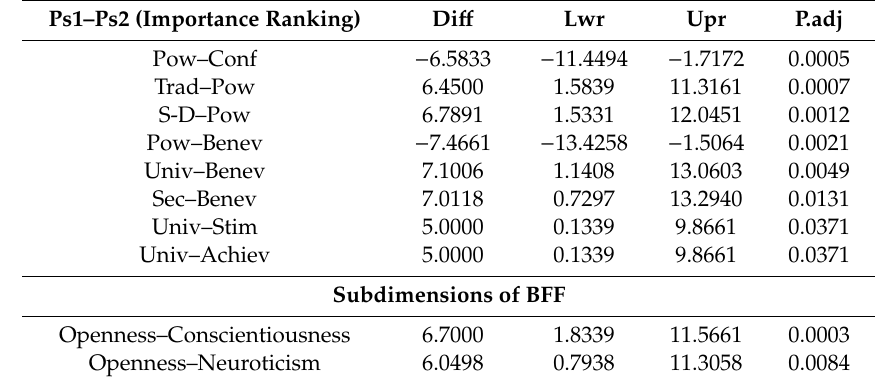
Figure 9. Multiple comparisons between all pairs (Tukey) in product categories for psychographic segmentation-based rating explaining (R 2 ). Figure 10. Multiple comparisons between all pairs (Tukey) in regression methods for psychographic segmentation-based rating prediction (RMSE).